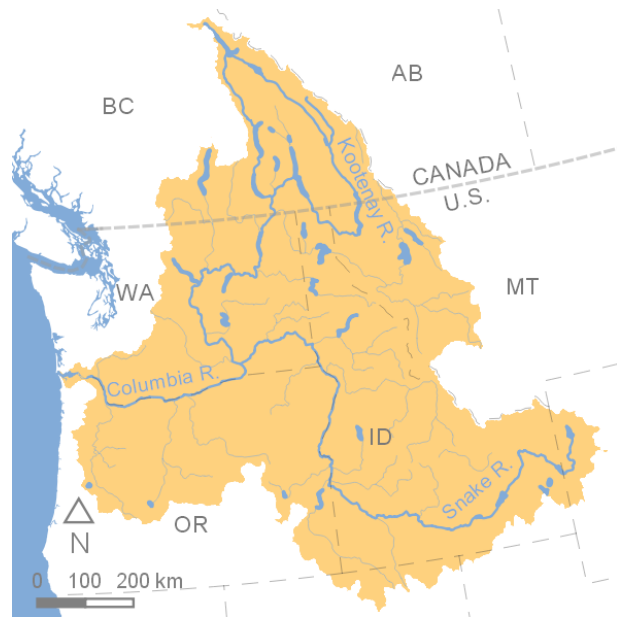
Fig. 1. Map of the Columbia River basin. Created by Hailey Eckstrand,